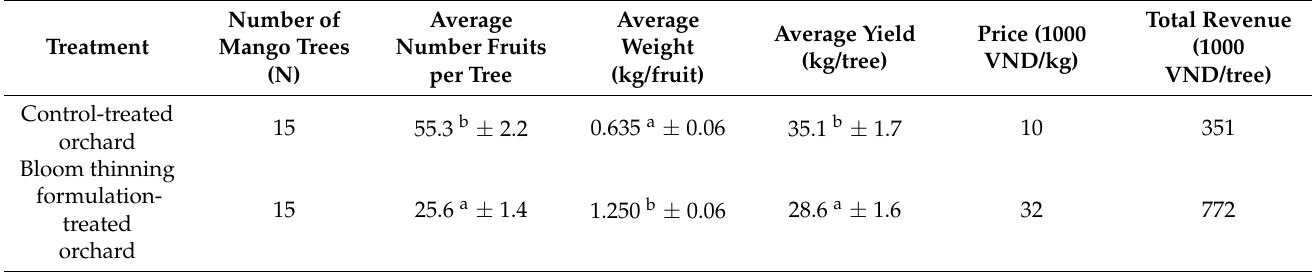
Table 2. Effects of organic bloom thinning formulation on mango trees.